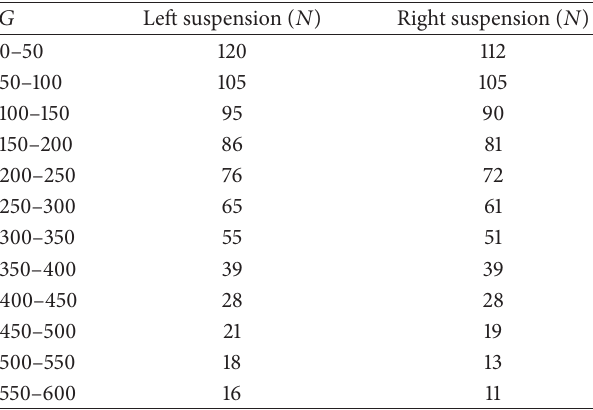
Table 1: Different maximum force values of suspension elements.